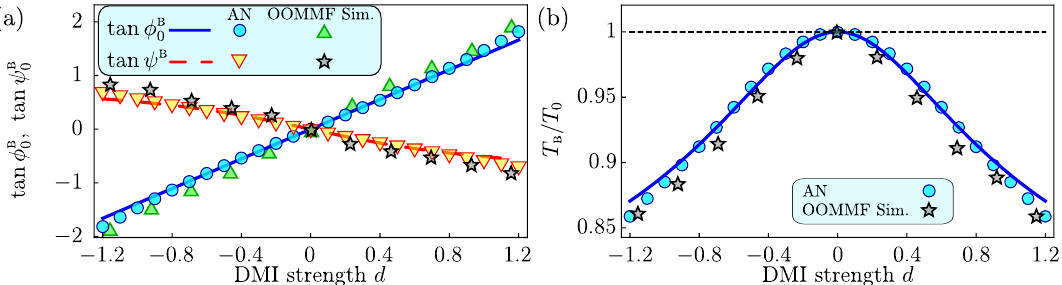
Figure 2: Parameters of periodical state in tubular shells: (a) and (b) show the angles φ B , ψ B , and period T as functions of DMI for (cid:99) ≈ 0.72. In (a), lines are B 0 / T = | cos ψ B | . Symbols plotted by means of (3); in (b), solid line is T 0 B